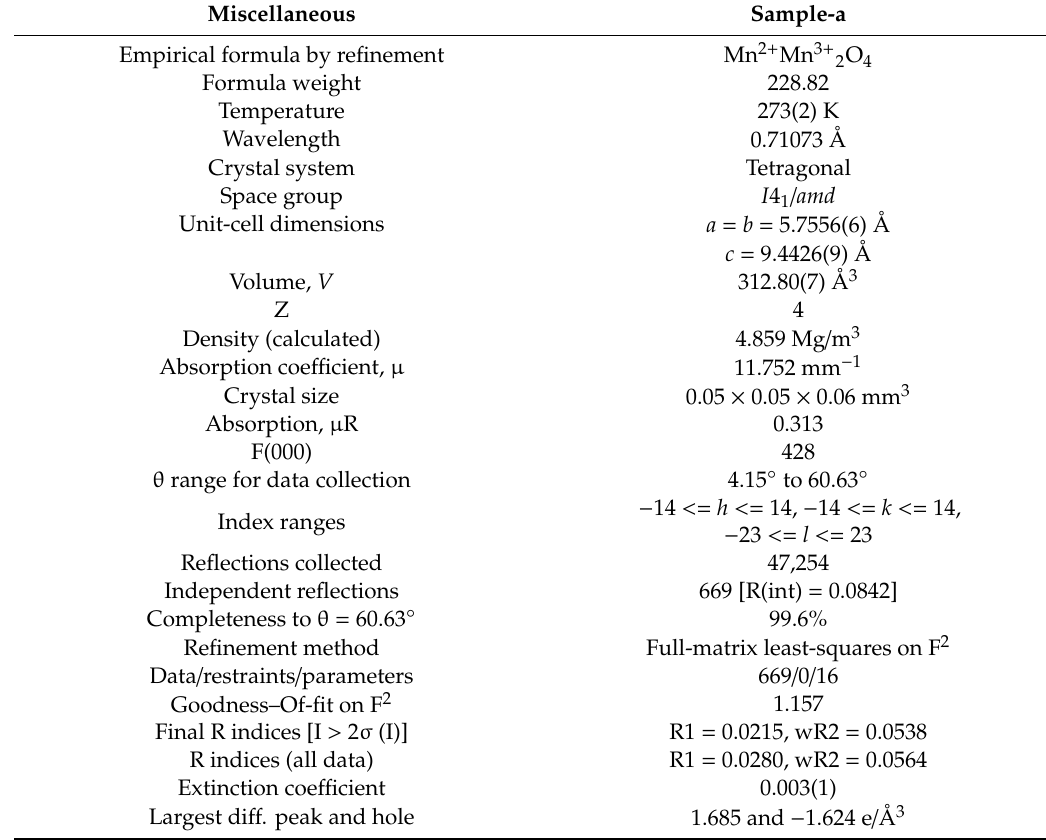
Table 3. Crystal structure refinement data for hausmannite sample-a (cif is given as a supplementary